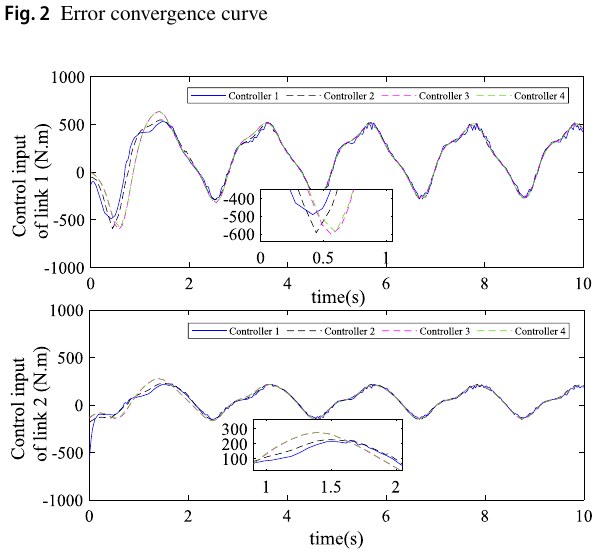
Fig. 3 Control input